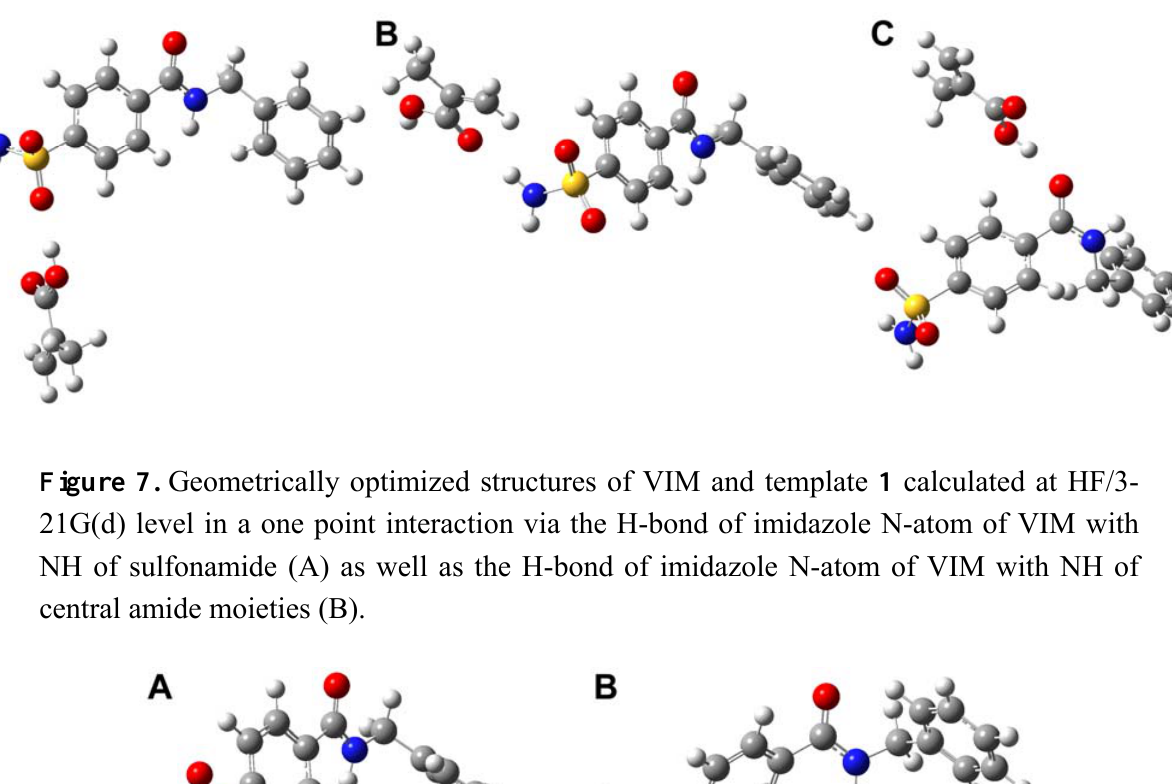
Figure 6. Geometrically optimized structures of MAA and template 1 calculated at HF/3- 21G(d) level in a one point interaction via the H-bond of sulfonyl O-atom with OH of carboxylic acid (A), H-bonding of amino sulfonyl with carbonyl O-atom of MAA (B), H- bond of carbonyl O-atom of amide with OH of carboxylic acid moieties.